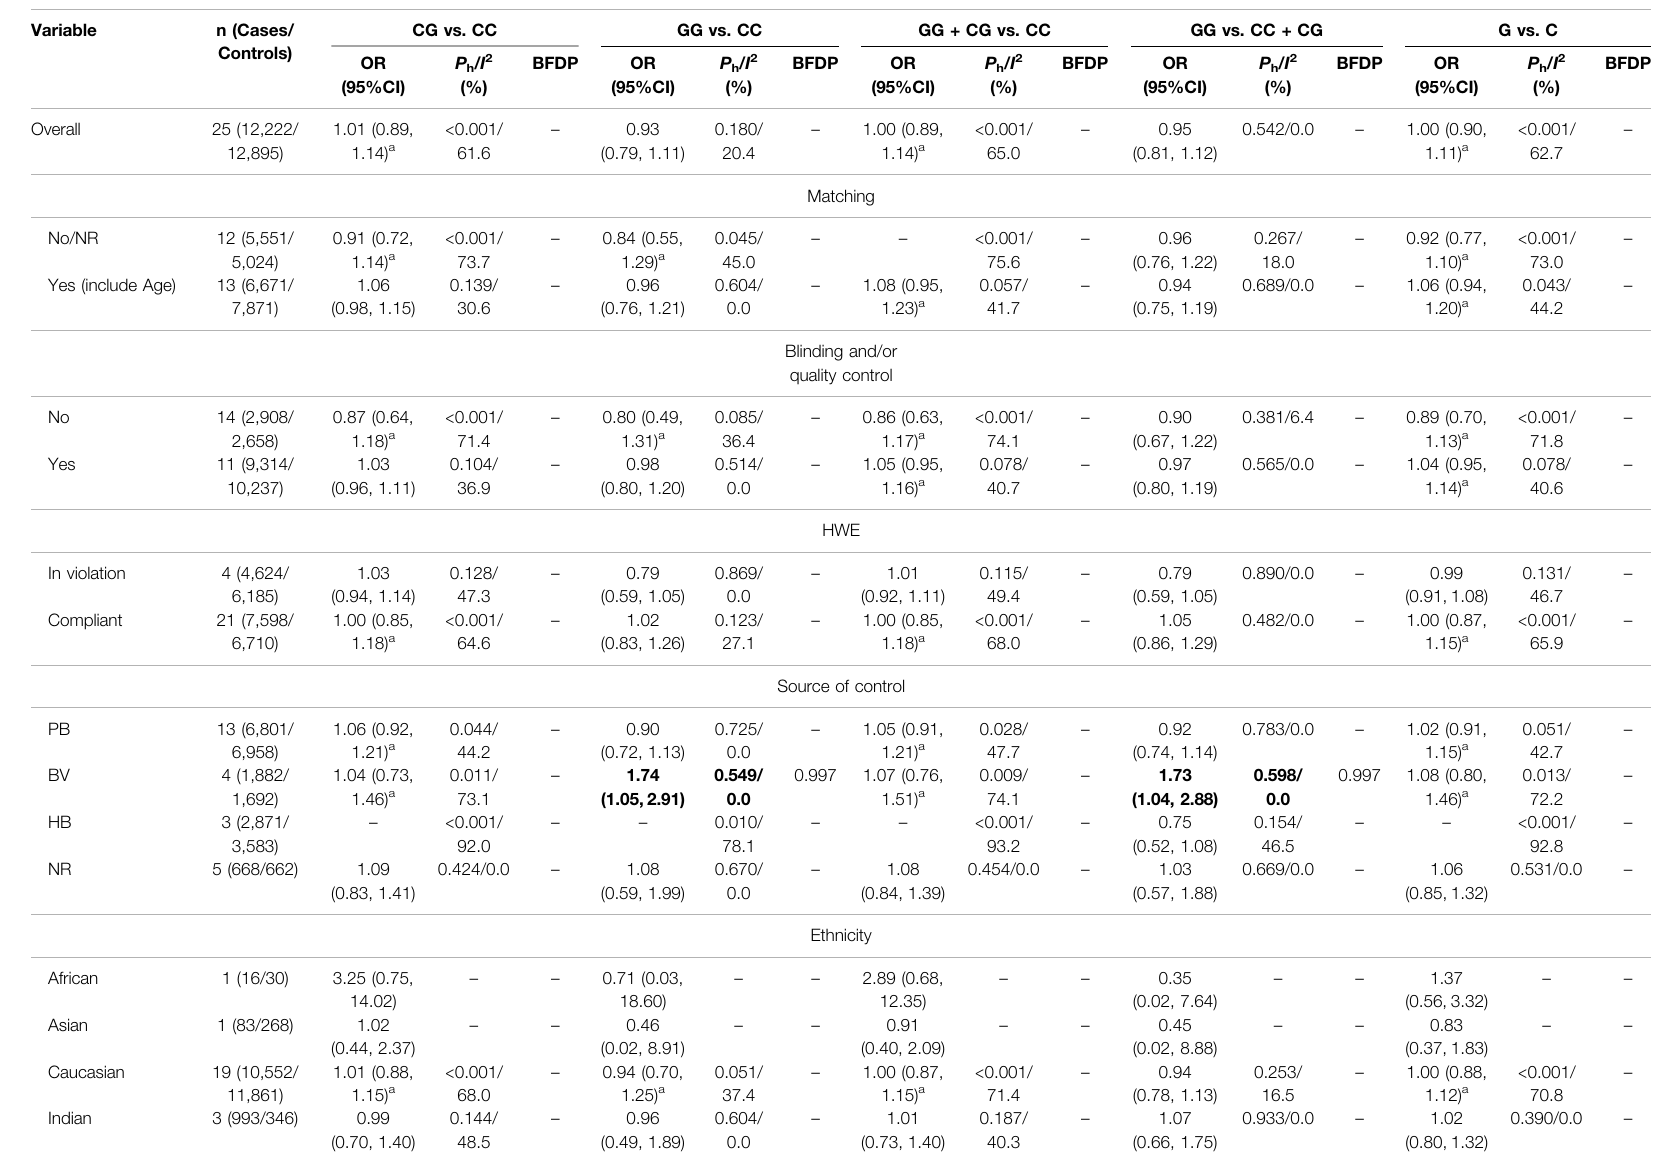
TABLE 4 | Pooled results on the association between the TP53 IVS6+62A > G (rs1625895) polymorphism and BC